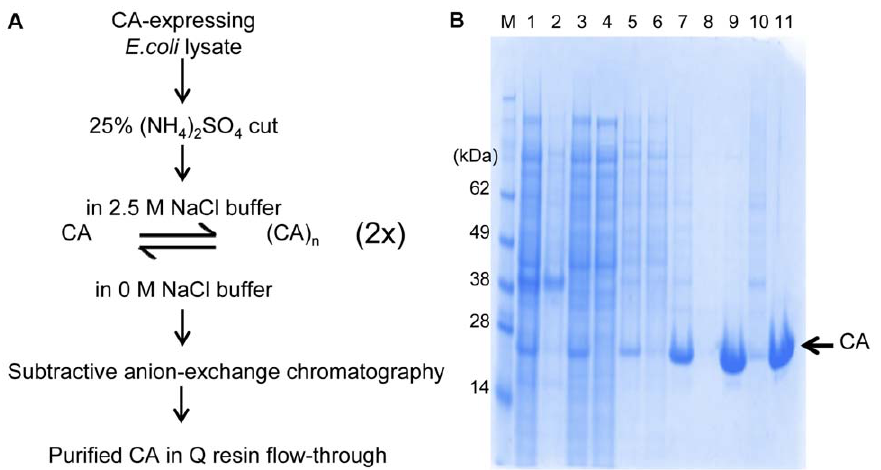
Figure 1. Functional purification of assembly-competent HIV-1 capsid proteins. ( A ) Flow diagram describes the functional purification scheme. Addition of NaCl to 2.5 M final concentration to the ammonium sulfate-saturated capsid solution and subsequent dissolution of the capsid- enriched pellet permits recovery of highly pure HIV-1 CA proteins after passage through the anion-exchange chromatography step. ( B ) SDS-PAGE analysis of fractions obtained during purification of wild-type capsid protein from E. coli lysate. The gel was stained with SimplyBlue TM Safe Stain. Lanes: M, SeeBlue Plus2 marker (the molecular weights of standards are depicted on the left-hand side of the gel); 1, total extract; 2, inclusion bodies; 3, soluble fraction; 4, supernatant after ammonium sulfate cut; 5, resolubilized 25% ammonium sulfate cut pellet; 6, unpolymerized fraction after 1 st addition to 2.5 M NaCl; 7, solubilized protein pellet fraction after first polymerization; 8, unpolymerized fraction after 2 nd addition of NaCl to 2.5 M final concentration; 9, solubilized protein pellet fraction after second polymerization; 10, insoluble pellet after dissolution of the polymerized capsid pellet from second round of polymerization; 11, Anion exchange chromatography flow-through of CA. Identity of the purified protein is confirmed by Time of Flight Mass Spectrometry (Figure S4).